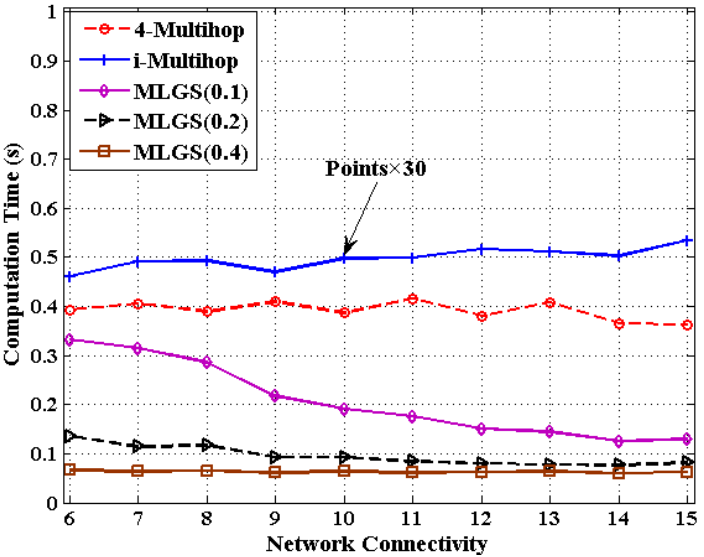
Figure 20. Computation cost versus network connectivity (isotropic network).